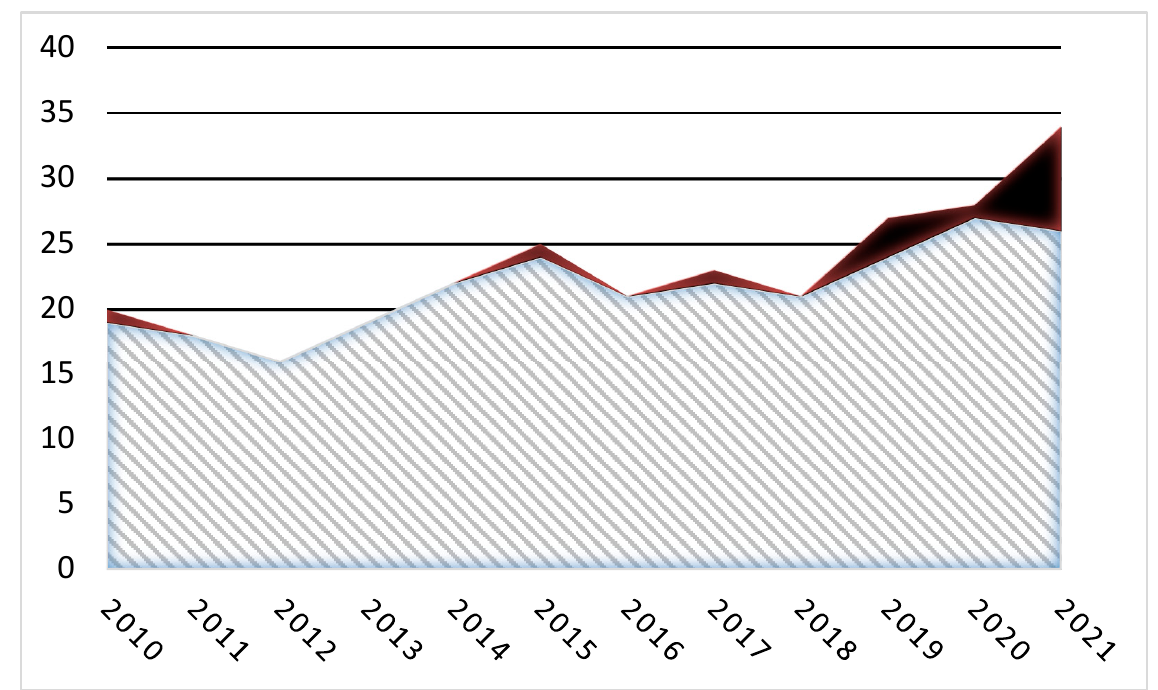
Figure 1. Numbers of patients with newly diagnosed GCA, including usual GCA and post-vaccine GCA, from 1 January 2010 to 31 December 2021. Gray shading, numbers of typical (e.g., without a vaccine trigger) GCA cases; black, post-vaccine cases. Table 2. DQB1 typing of 20 patients with post-COVID-19 vaccine